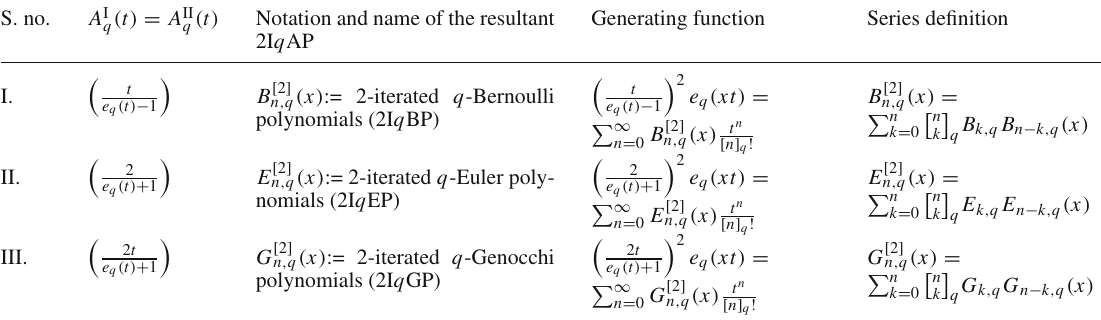
Generating function Series definition